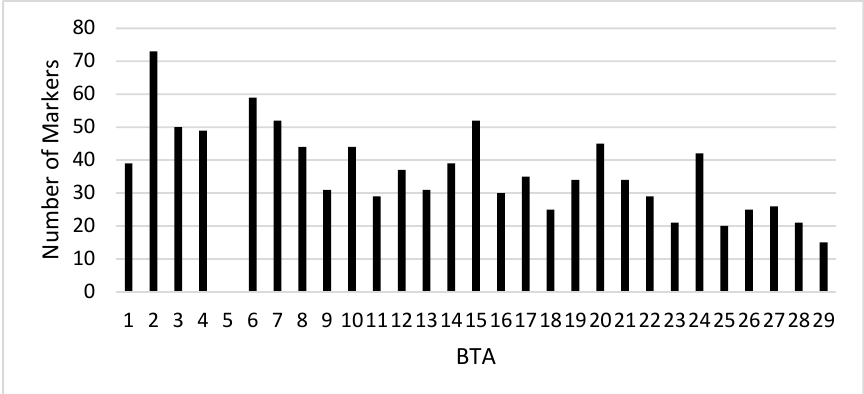
Figure 2. Distribution across the genome of 1031 markers selected in the multivariate GWAS for the first seven traits (body weight (BW), average daily gain (ADG), carcass weight (CW), dressing percentage (DP), shank circumference (SC), head weight (HW) and pH at slaughter (pH)).